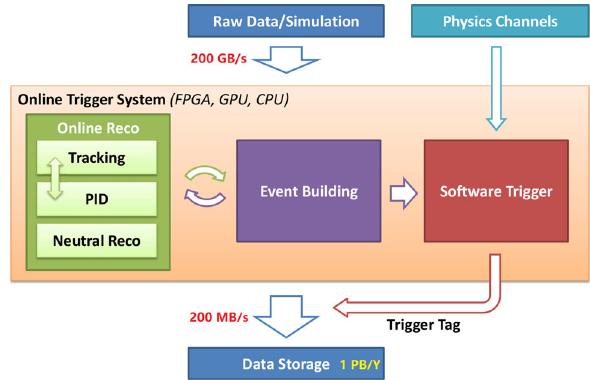
Fig. 2 SchematicoverviewofthecompletePANDAonlinetriggersys- tem